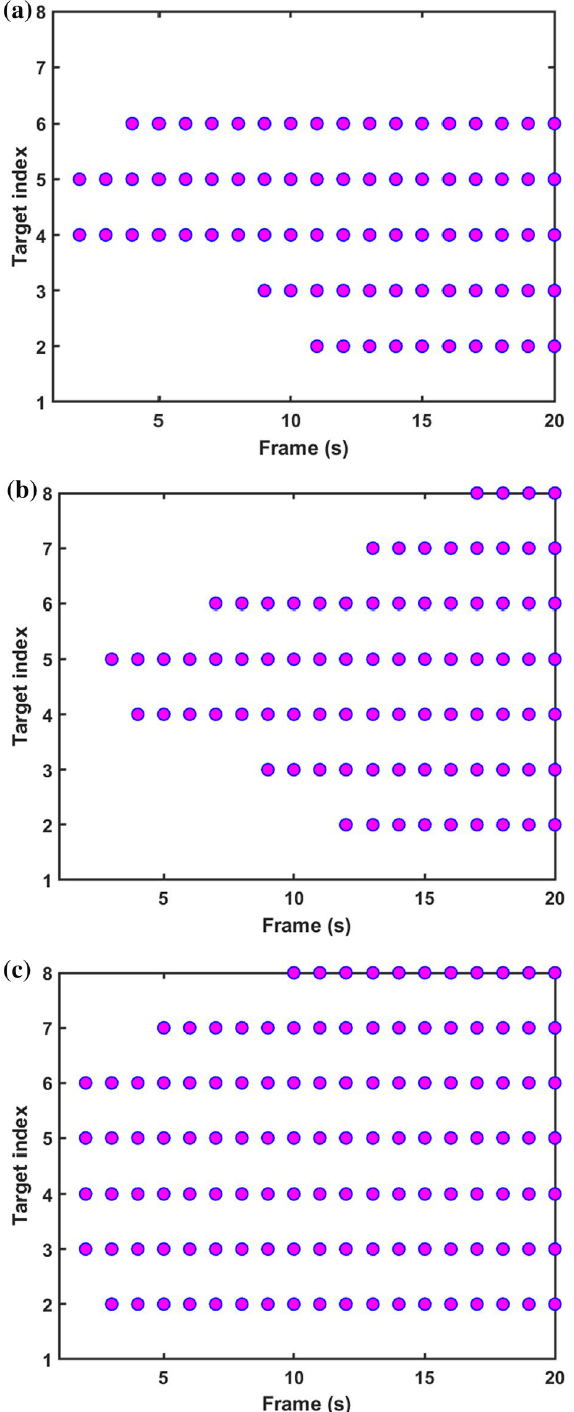
Fig. 9 Indices of the effective tracking targets. a Uniform allocation. b Sum-max optimize allocation. c Proposed RPA